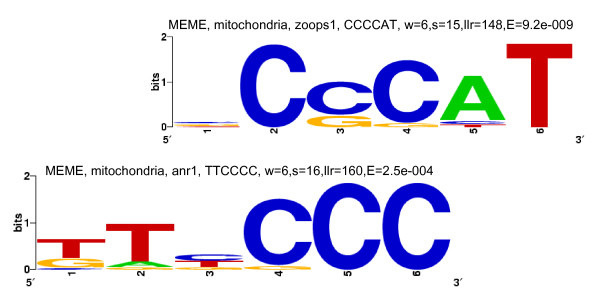
Sequence logos for C-rich motif-sets identified by MEME in the upstream regions of the set of 15 mitochondrial genes. Motif-sets are given in Additional file 2:37 and logo captions are explained in the legend to Figure 1.